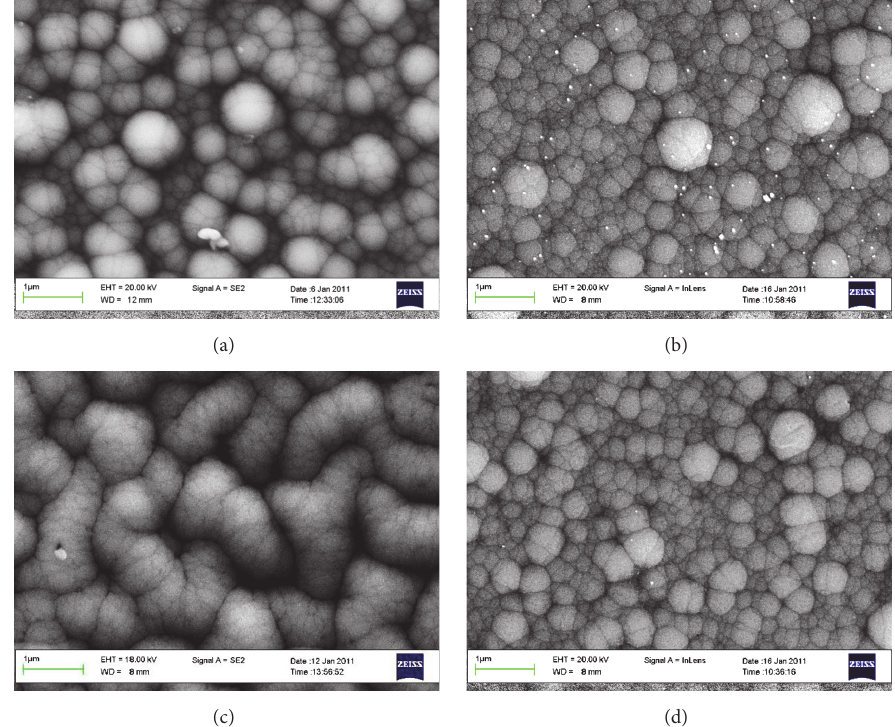
Figure 1: FE-SEM micrographs of the pulsed-electrodeposited Co-Ni-P films before annealing (a) and magnetic annealing in the case of (b) 𝐵 = 0 T, (c) 𝐵 = 6 T, and (d) 𝐵 = 12 T.